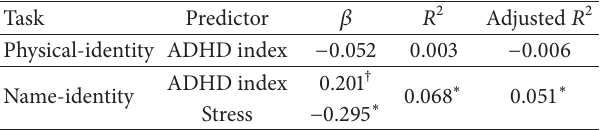
Table 3: The final models of multivariable regression analyses predicting interhemispheric interaction index in each task from the ADHD index subscale of the CAARS and the backward selection of the DASS subscales.